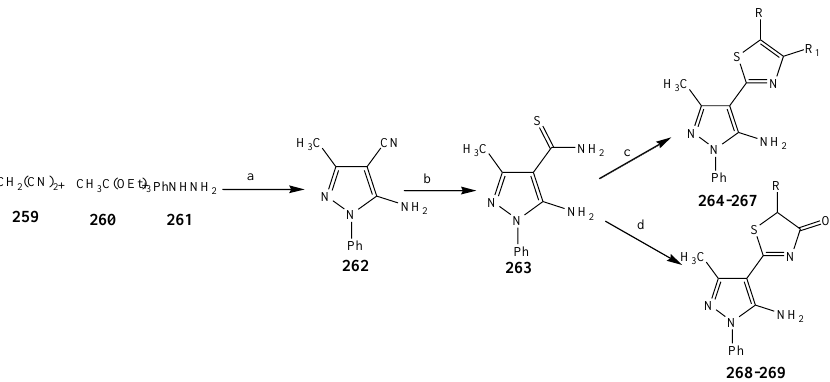
Scheme 18. Synthesis of thiazole from thiourea ( 253 – 256 ).